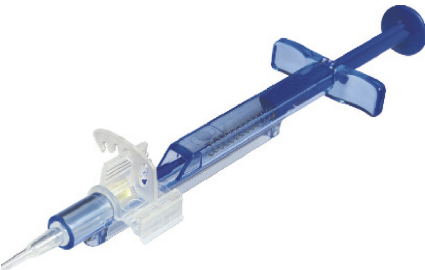
Figure 4: Fully preloaded